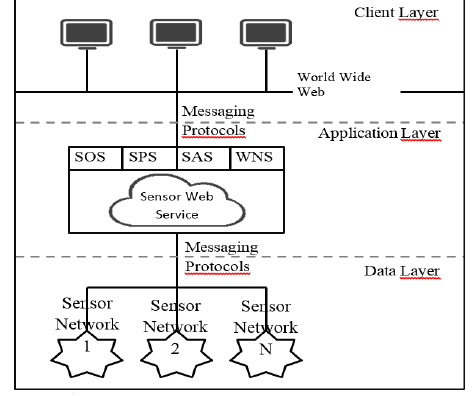
Figure 1. General architecture of an IoT